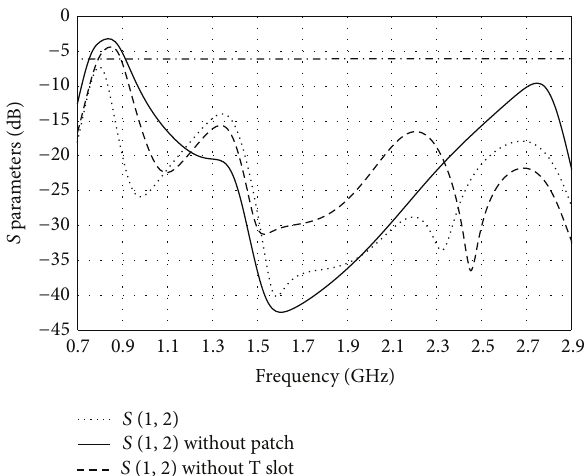
Figure7: 𝑆 12 (dB)withthepatchandT-shapedslot; 𝑆 12 (dB)without the patch and 𝑆 12 (dB) without the T-shaped slot.